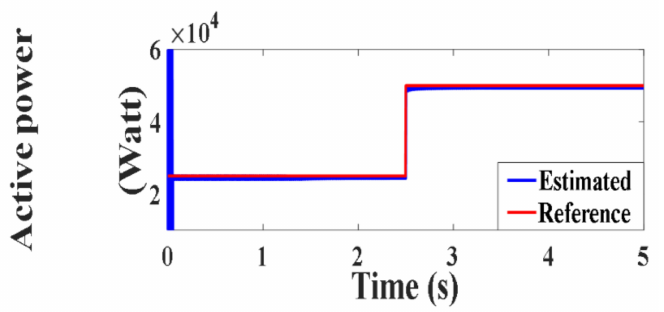
Figure 17. Active power under SVOC (Watt).